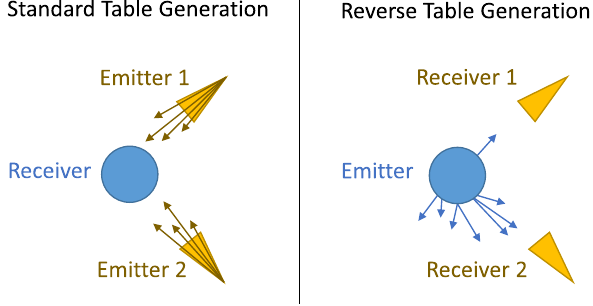
Fig. 9 Illustration of photon tables generated in the standard approach (left) and the reverse retro approach (right). The circle in blue color denotes an IceCube DOM, and the triangles in yellow Cherenkov light sources